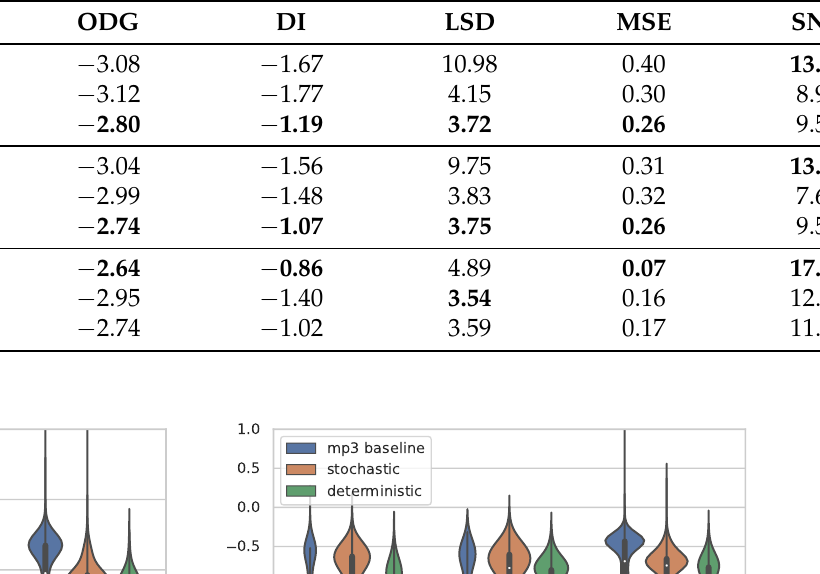
Table 2. Results of objective metrics for stochastic ( sto ) and deterministic ( det ) models and MP3 baselines ( mp3 ) for different compression rates (16 kbit/s, 32 kbit/s, 64 kbit/s). Higher values are better for ODG, DI and SNR; lower values are better for LSD and MSE.